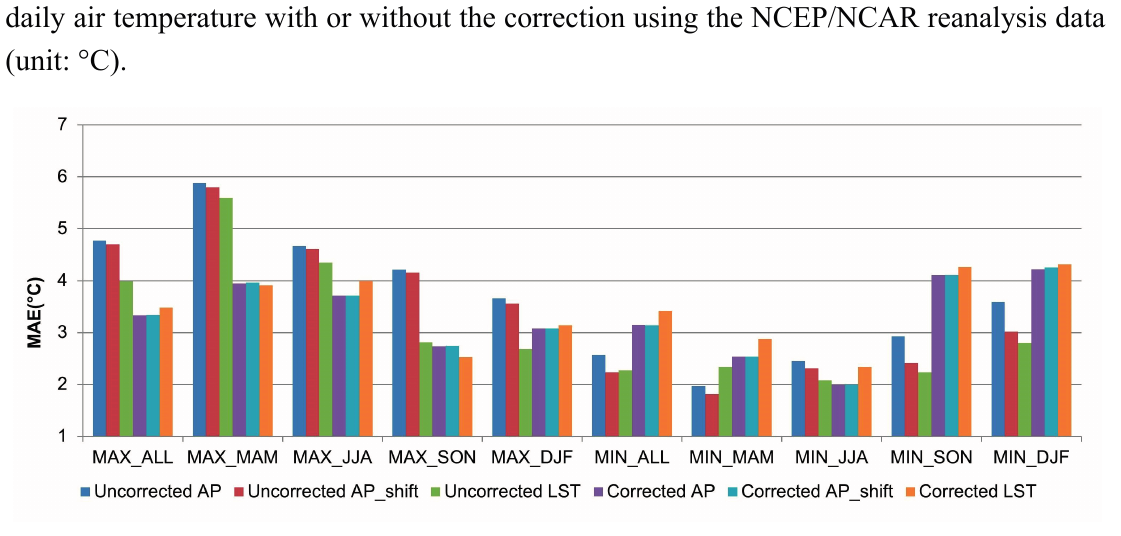
Figure 4. RMSE values averaged for 60 ASOS weather stations’ locations for estimating daily air temperature with or without the correction using the NCEP/NCAR reanalysis data (unit: